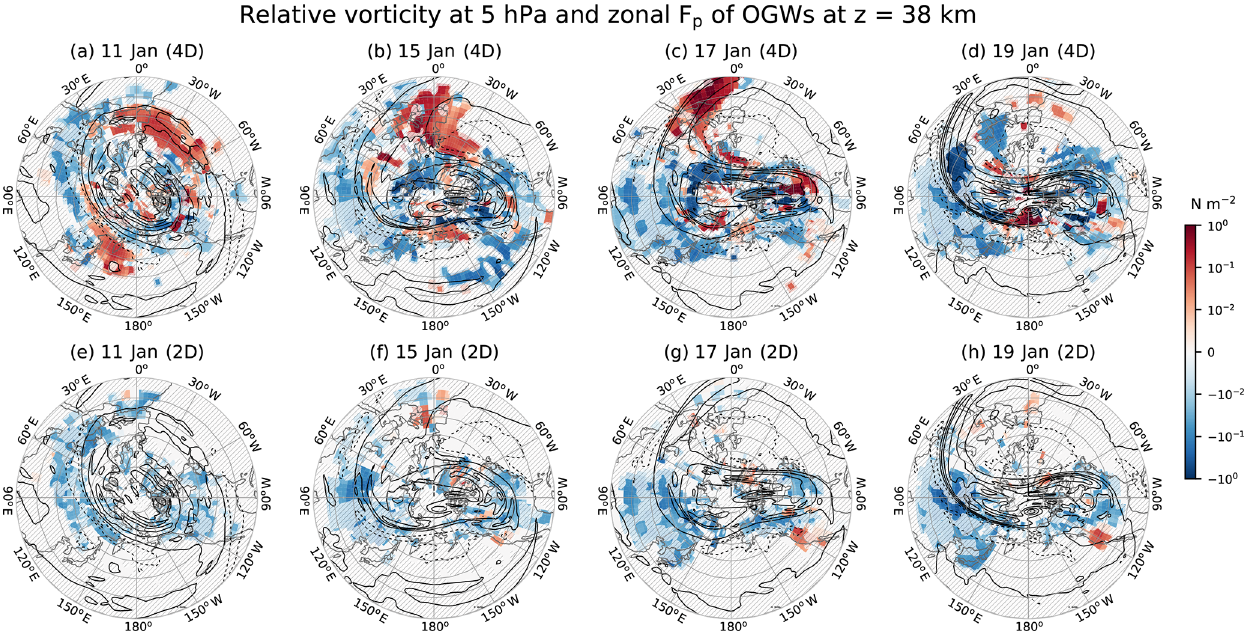
Figure 13. Relative vorticity at 5hPa and zonal pseudomomentum fluxes ( F p ) for OGW at z = 38km at 00:00UTC on (a, e) 11 (b, f) , 15 (c, g) 17, and (d, h) 19 January in 2009 for the (top row) 4D and (bottom row) 2D experiments. OGW F p is multiplied by the efficiency factor (0.125). Contour interval for relative vorticity is 5 × 10 − 5 s − 1 , and negative values are plotted in broken lines. Hatched areas over the zonal F p indicate regions where the paired and two-tailed t test for the 4D and 2D experiments give p values larger than 0.05 (i.e., no statistical significance at the level of 0.05). Latitudinal grids are plotted for every 10 from 20 ◦ N.